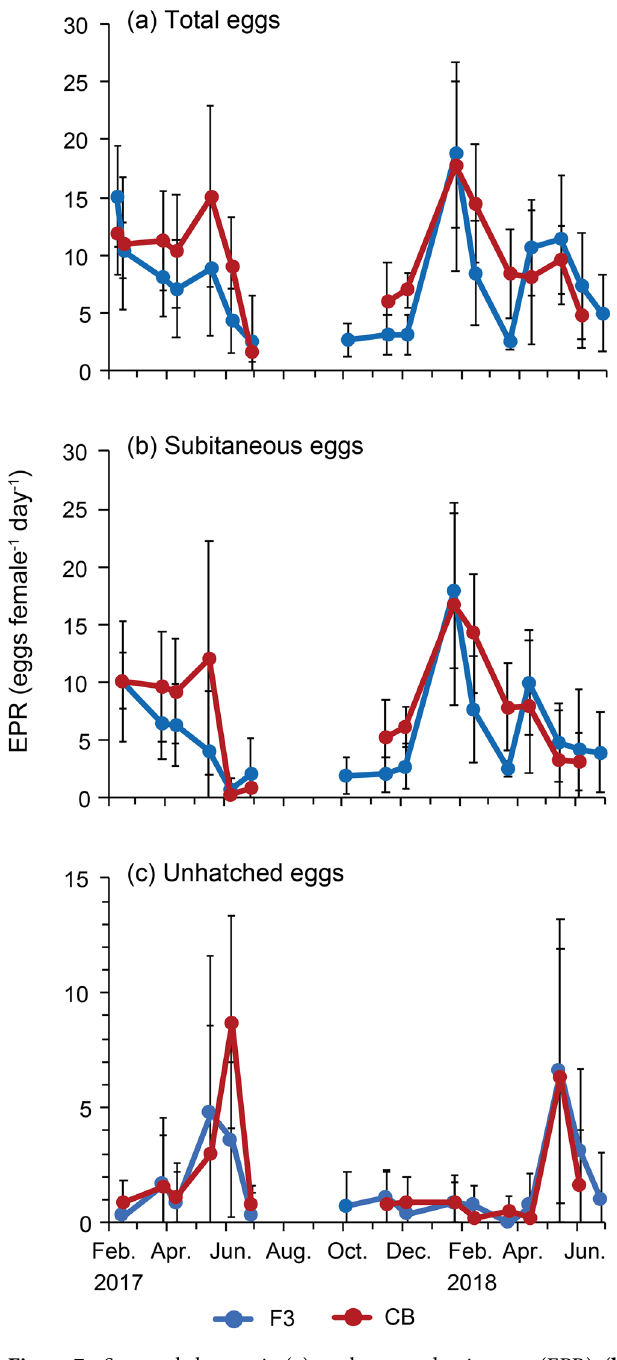
Figure 7. Seasonal changes in ( a ) total egg production rate (EPR), ( b ) Subitaneous EPR and ( c ) unhatched EPR of Acartia omorii at St. F3 and St. CB from February 2017 through June 2018. Error bars denote ± SD. *: significant difference between St. F3 and St. CB (Turkey’s post-hoc test: p <